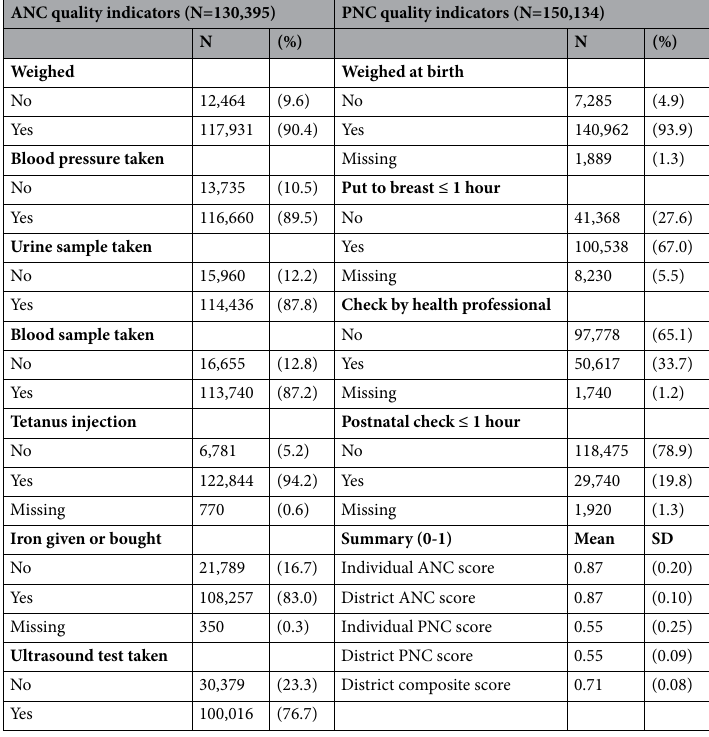
Table 2. Service items for antenatal care (ANC) and postnatal care (PNC) at individual and district